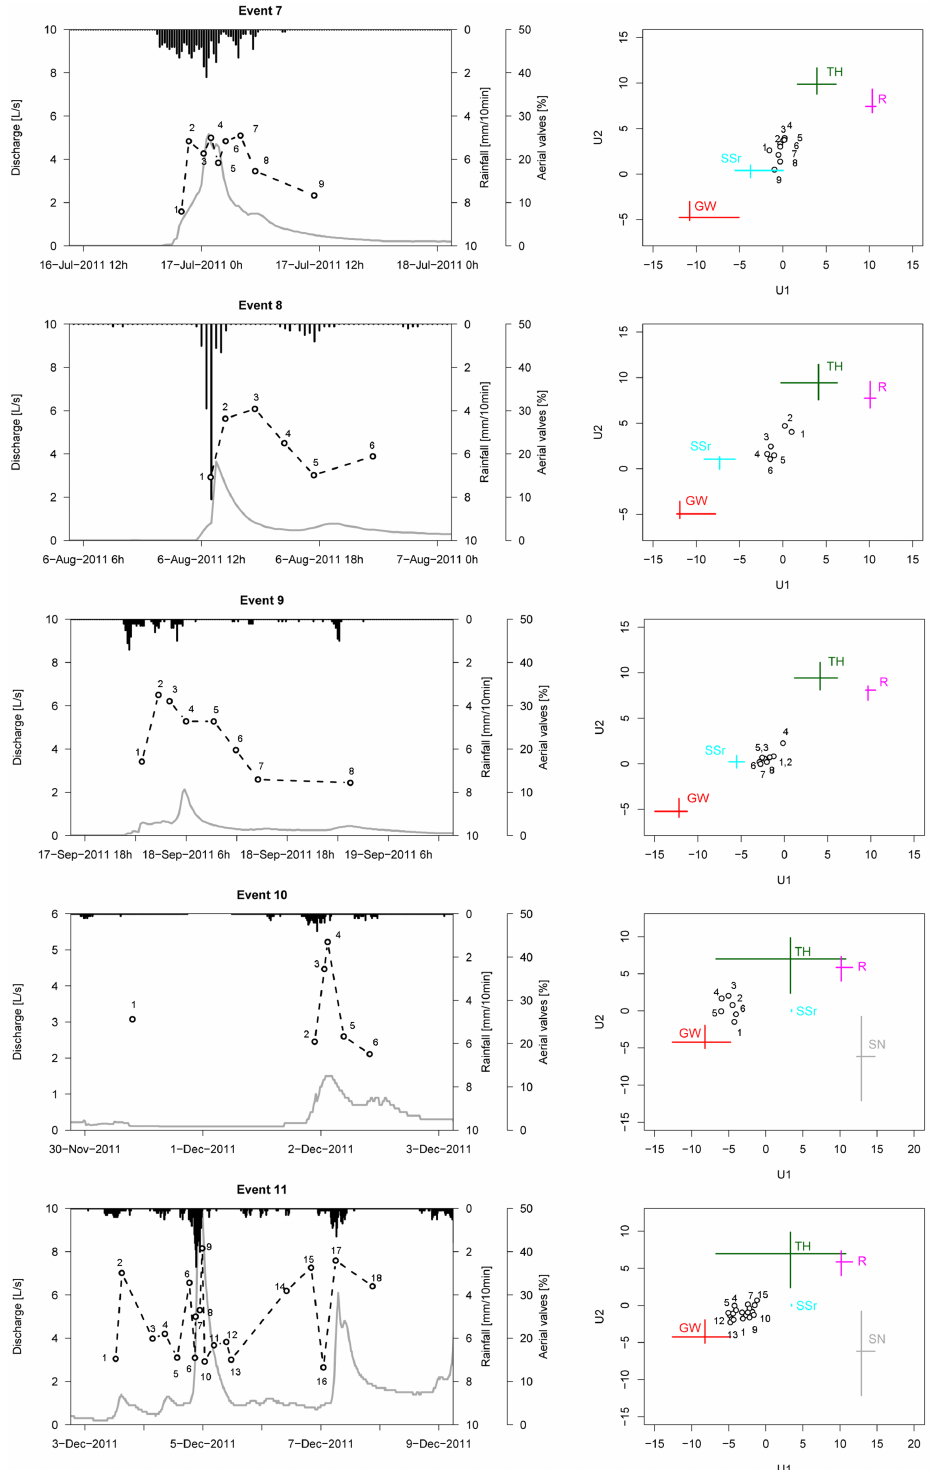
Figure 9. Hydrograph, hyetograph and percentage of aerial valves in the stream water for events 7–11 in the Weierbach catchment (left), and U1–U2 mixing diagrams for each event. End-members are rainfall (R), throughfall (TH), snow (SN), soil water (SS), soil water from the riparian zone (SSr) and groundwater (GW). Bars represent end-member values’ interquartile ranges of samples collected during the month when the event occurred, as well as the previous and following